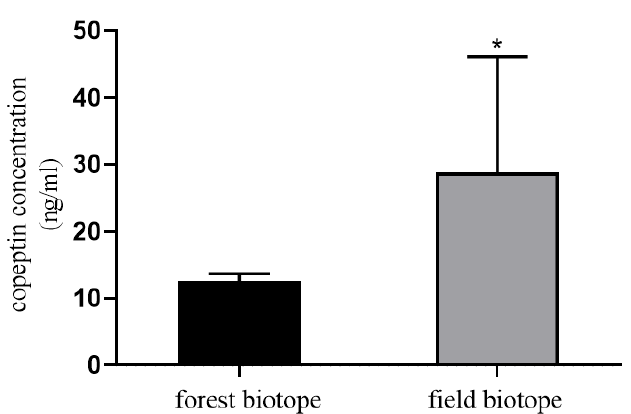
Figure 1. Copeptin concentration in blood plasma of roe deer from forest and field ecotype. Statistical differences were evaluated by t-test using GraphPad Prism. Asterisk (*) means statistical difference: p < 0.05.